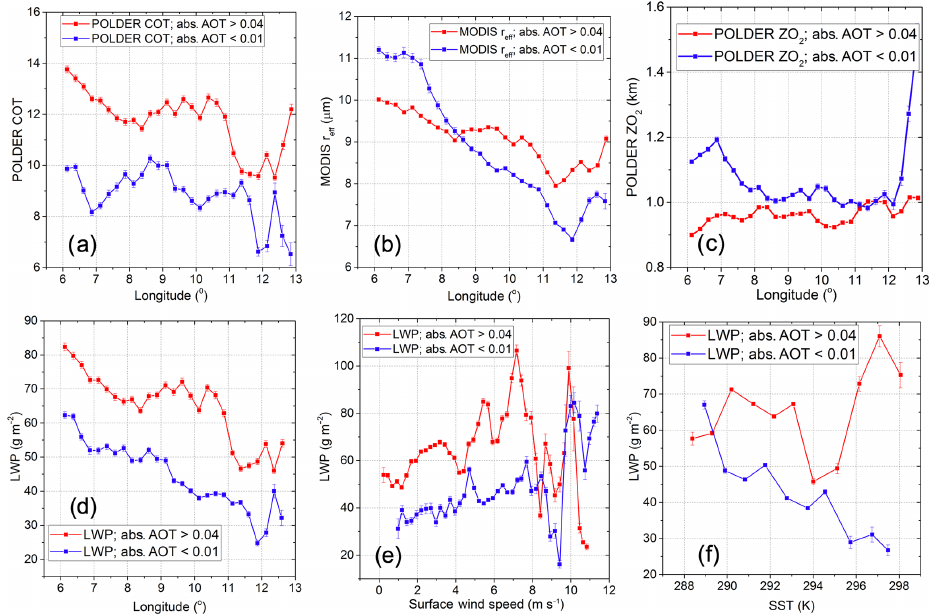
Figure 10. Mean values of POLDER COT (a) , MODIS r eff , (b) POLDER ZO 2 (c) and liquid water path (LWP) (d) as a function of longitude. Mean values of LWP as a function of meteorological parameters: surface wind speed (e) and sea surface temperature (SST) (f) are also presented. The data are separated into situations with POLDER absorption AOT 865nm smaller than 0.01 (red lines) and with POLDER absorption AOT 865nm larger than 0.04 (blue